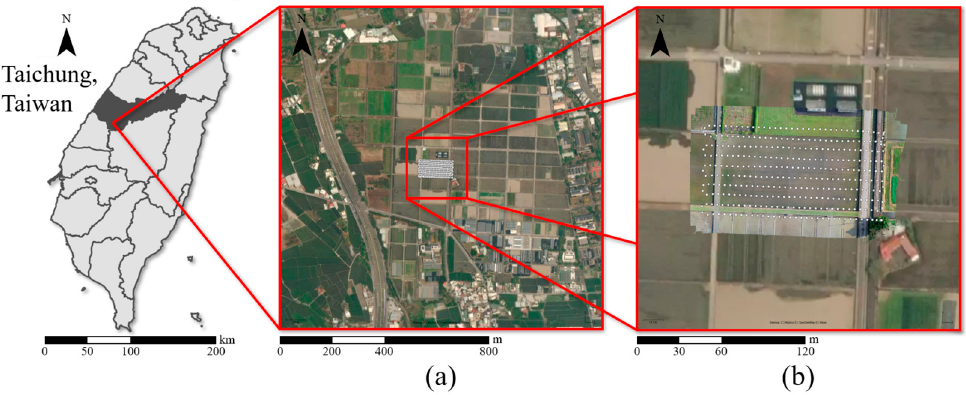
Figure 2. ( a ) The data collecting area over a satellite image; ( b ) the flight routes (white dots) and orthomosaic image. Table 3. Information of UAV training-validation data collection